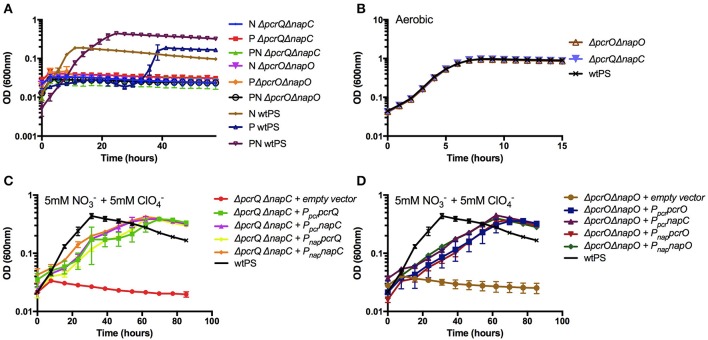
Growth of ΔpcrQΔnapC and ΔpcrOΔnapO. (A) Growth phenotype of wtPS, ΔpcrQΔnapC, and ΔpcrOΔnapO, on LMM medium containing nitrate (N), perchlorate (P), both nitrate and perchlorate (PN), and (B) oxygen were tested. (C,D) Growth of ΔpcrQΔnapC with complementation vectors expressing pcrQ or napC, and ΔpcrOΔnapO with complementation vectors expressing pcrO or napO, on LMM medium with nitrate and perchlorate. Complementation tests were conducted with either pcr or nap promoter (Ppcr and Pnap). Error bars represent standard deviations of biological triplicate samples.